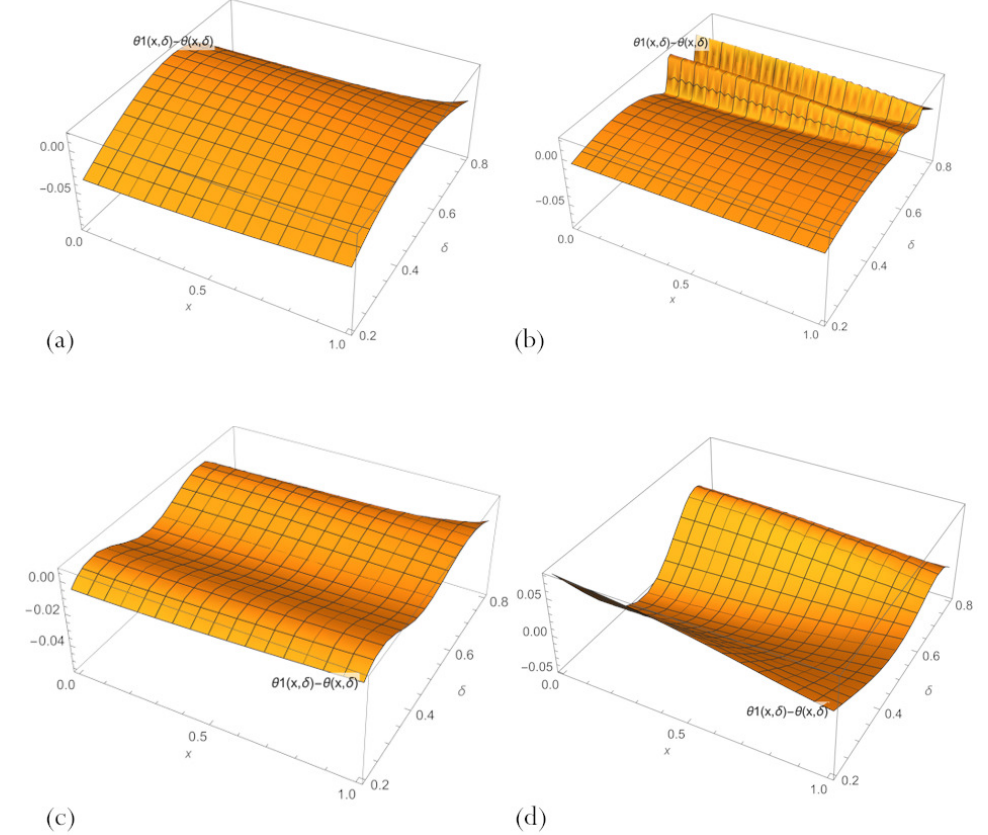
Figure 6. Errors in PBA-PINN (20) for ( a ) n = 3 and ( b ) n = 10, ( c ) in PBA-PINN (23) for n = 3, N = 1, and ( d ) in classical PINN with n = 20 neurons of a hidden layer and activation function (18), across parameter space 0.2 < δ < 0.8, after learning by minimising the loss